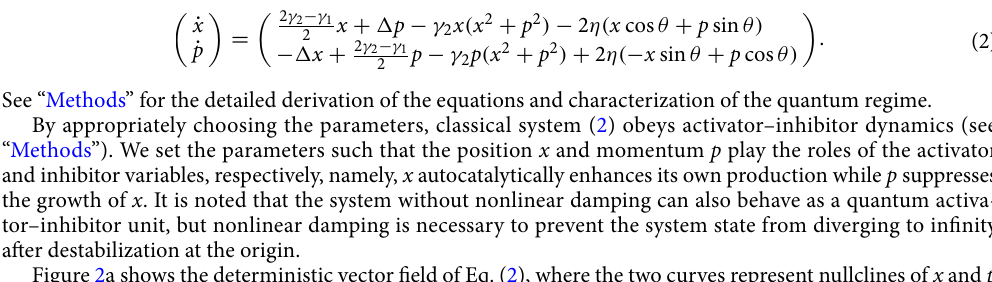
0 , respectively. ( b ) Stochastic trajectory of ( x , p ) 0 and p x ˙ = ˙ = 0.3 0.6, γ 1 0.4, γ 2 0.1, θ π , and η = = − = = =